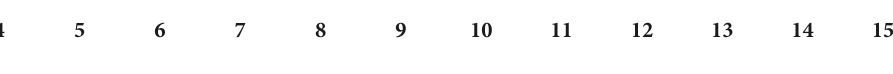
TABLE 6 Correlation between Yale Food Addiction Scale 2.0 (YFAS 2.0) and other variables N =